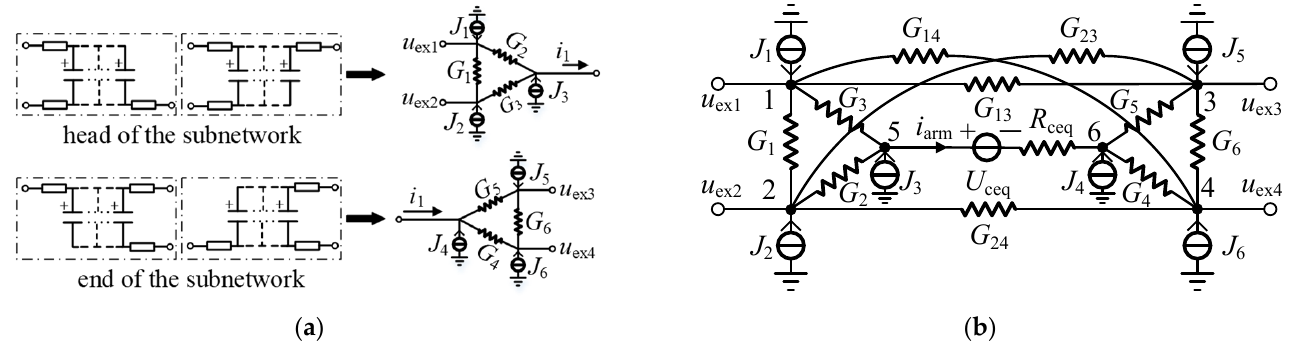
Figure 9. Equivalent model considering the parallel combination of submodules: ( a ) equivalent circuit of three-terminal submodule parallel combination; ( b ) unified equivalent model of PFBSM networks.